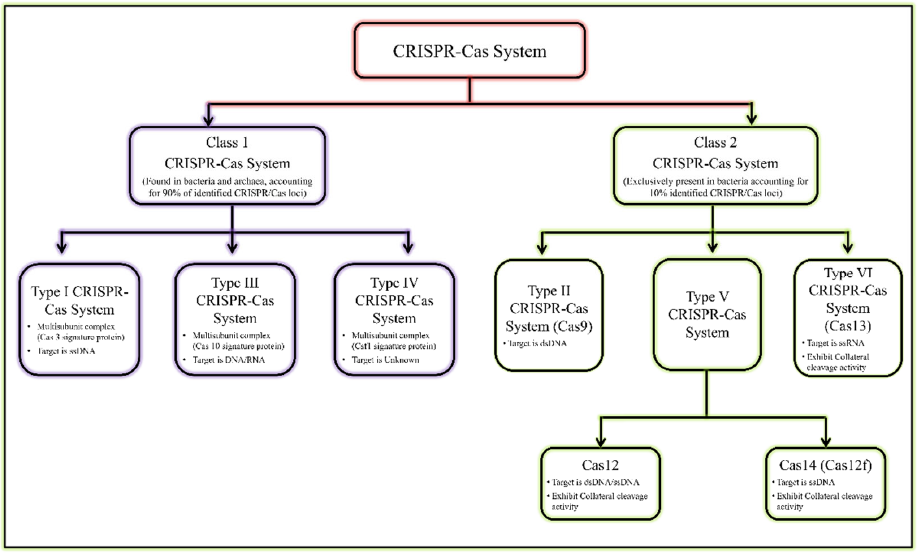
Figure 1. General classification of CRISPR/Cas system.